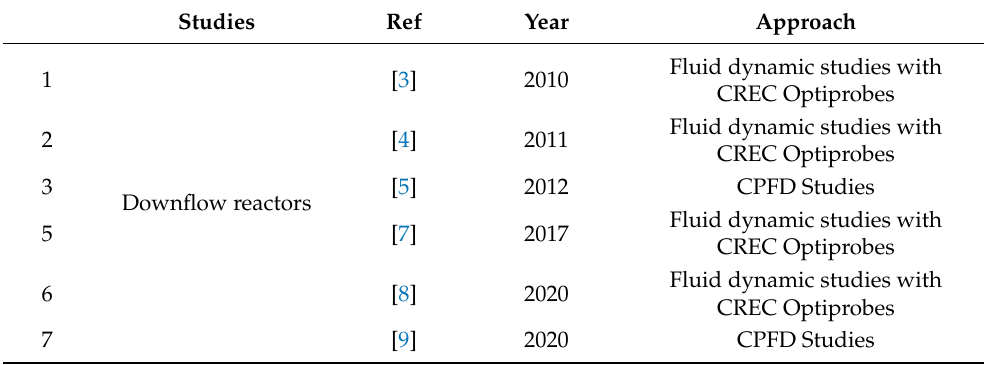
Table 1. Fluid Dynamics and CFD Studies in Downers Stressing the Importance of Particle Clusters.